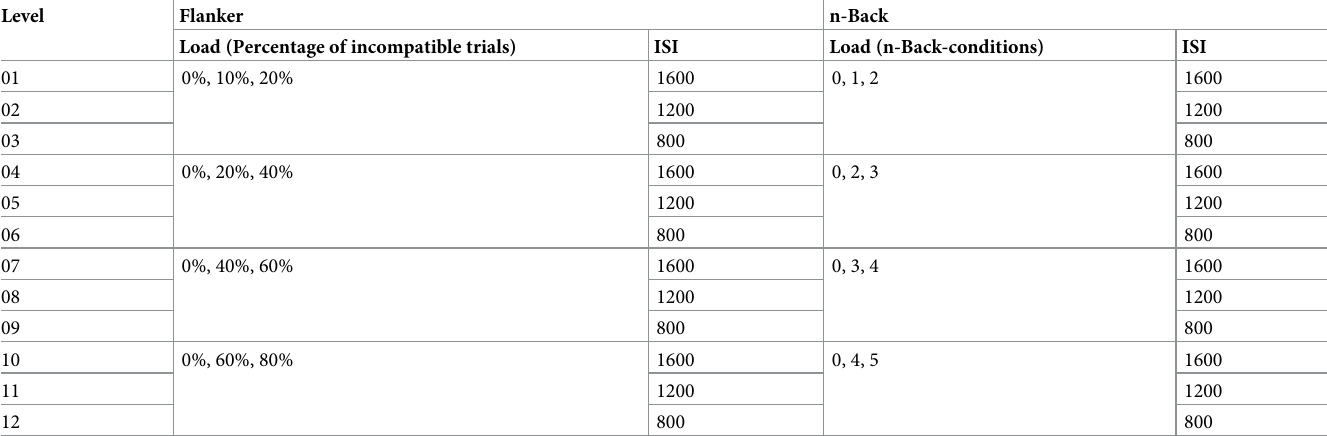
Table 1. Difficulty levels in the flanker and nback task in the adaptive training procedure. Interstimulusinterval (ISI) is reported in